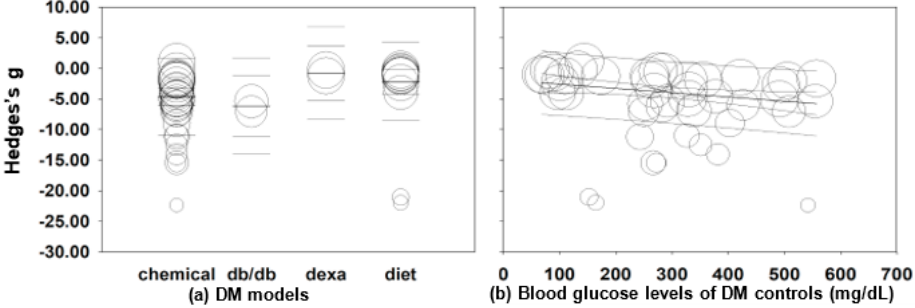
Figure 3. Meta-regression analyses for Hedges’ g of blood glucose levels and DM models ( a ) or blood glucose levels of DM controls (mg/dL) ( b ). Summary estimates were analyzed using a random-effects model.